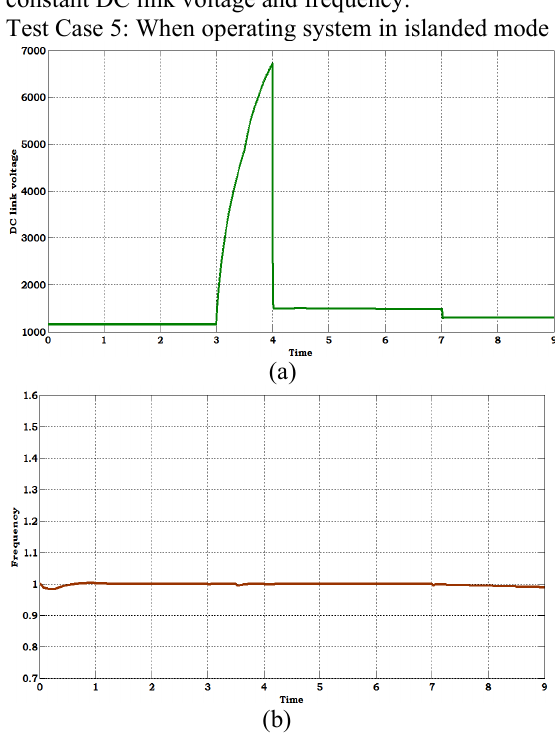
Figure 20. (a). DC link voltage, (b).Frequency